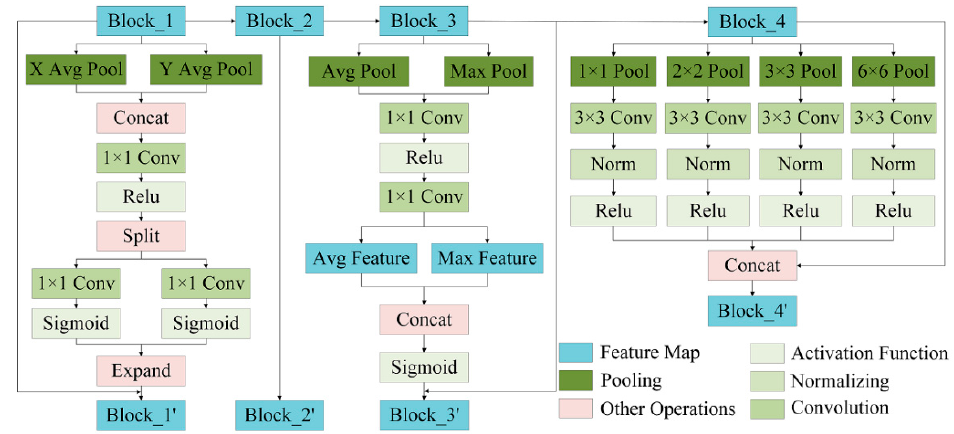
Figure 2. The detailed structure of Hierarchical Feature Extraction (HFE).